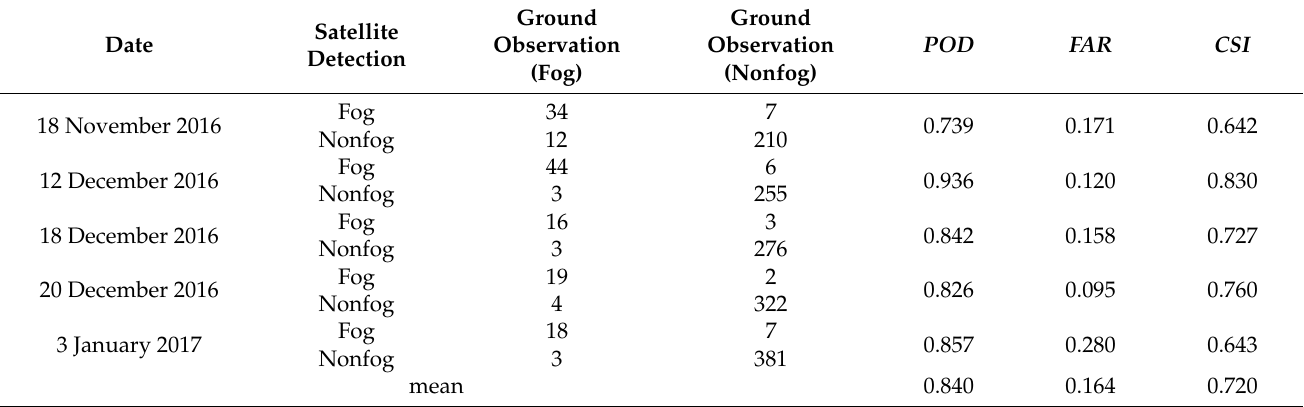
Figure 7. The fog detection results at ( a ) 15:30, ( b ) 16:00, ( c ) 16:30 and ( d ) 17:00 on 18 November 2016. The triangle, star, circle, and cross symbols represent haze, dense fog, strong fog, and non-fog stations, respectively. The square symbol indicates that there is no observation data because of the limit monitoring frequency. The blue area is the fog detected by our algorithm. All the times are at the Beijing Time (8 h later than the Universal Time Coordinated (UTC)) and the green line is the terminator line. Table 2. Fog detection accuracy at 08:00